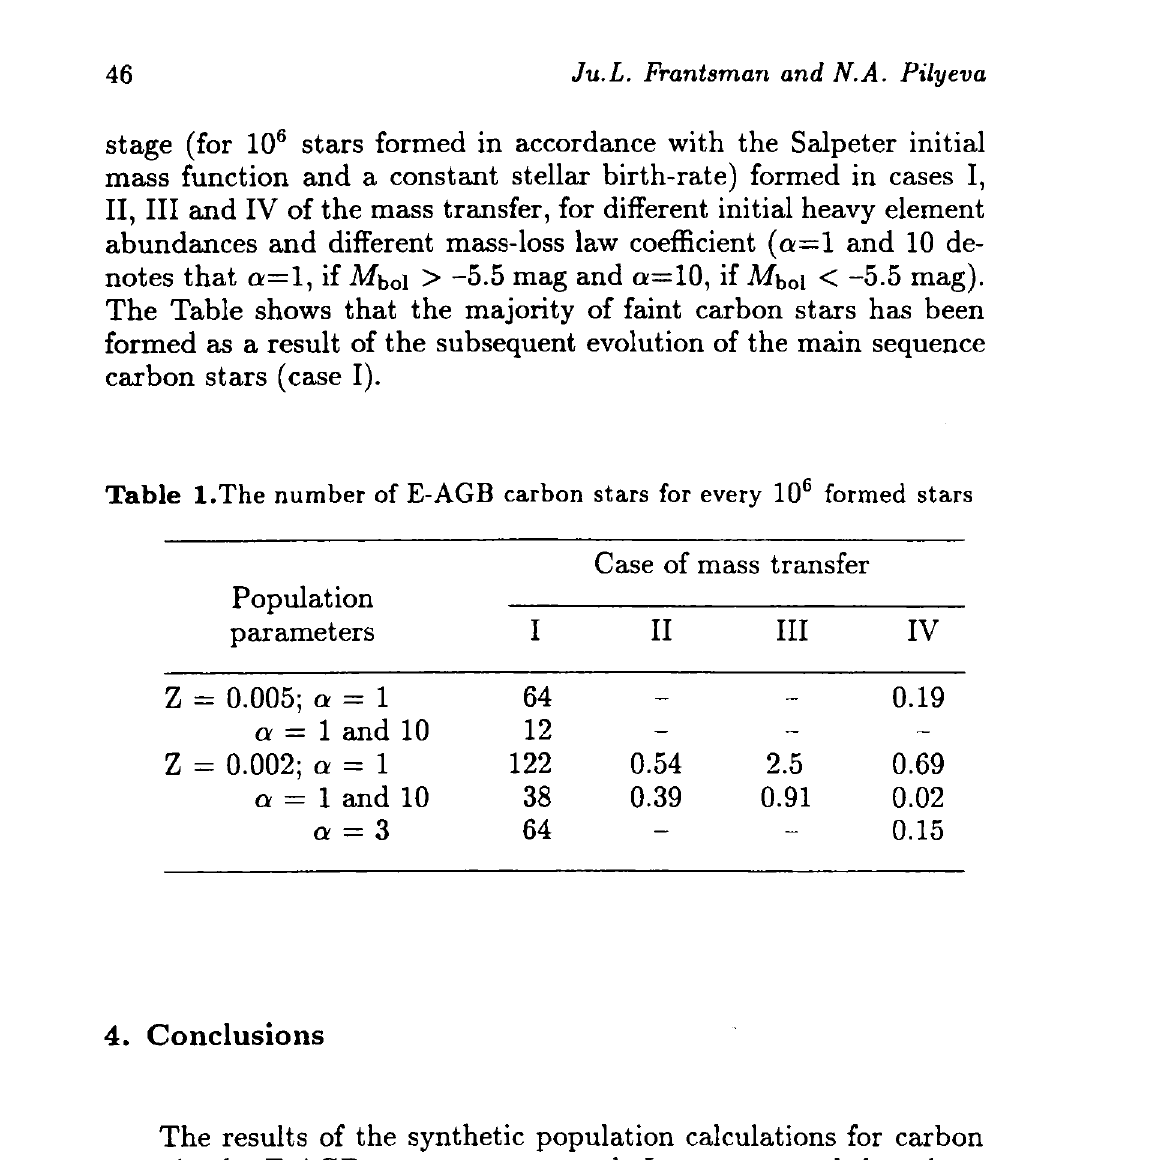
Table l.The number of E-AGB carbon stars for every 10 6 formed